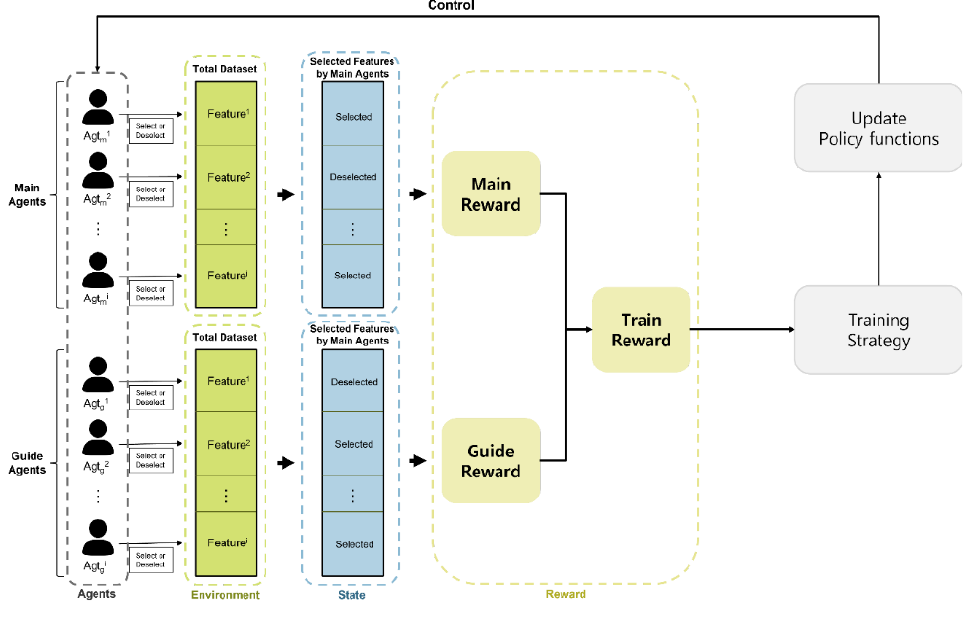
Figure 2. Framework